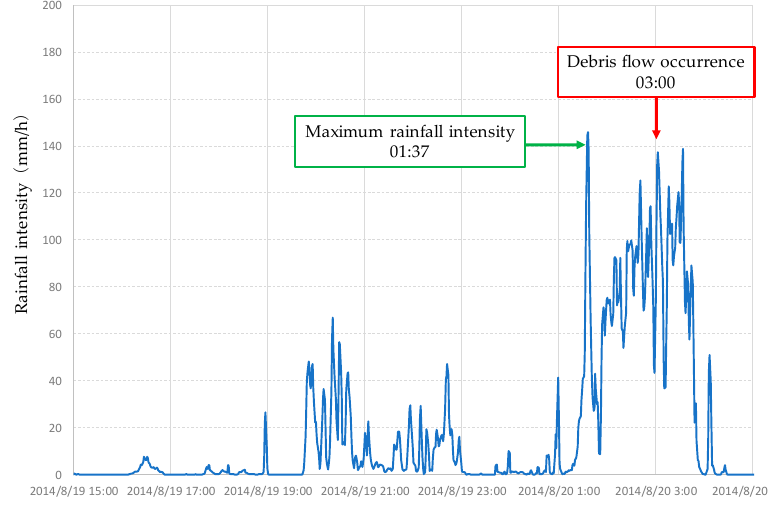
Figure 6. Temporal change of rainfall intensity at Asaminami, Hiroshima (Data source: Japanese Ministry of Land, Infrastructure, Transport and Tourism).